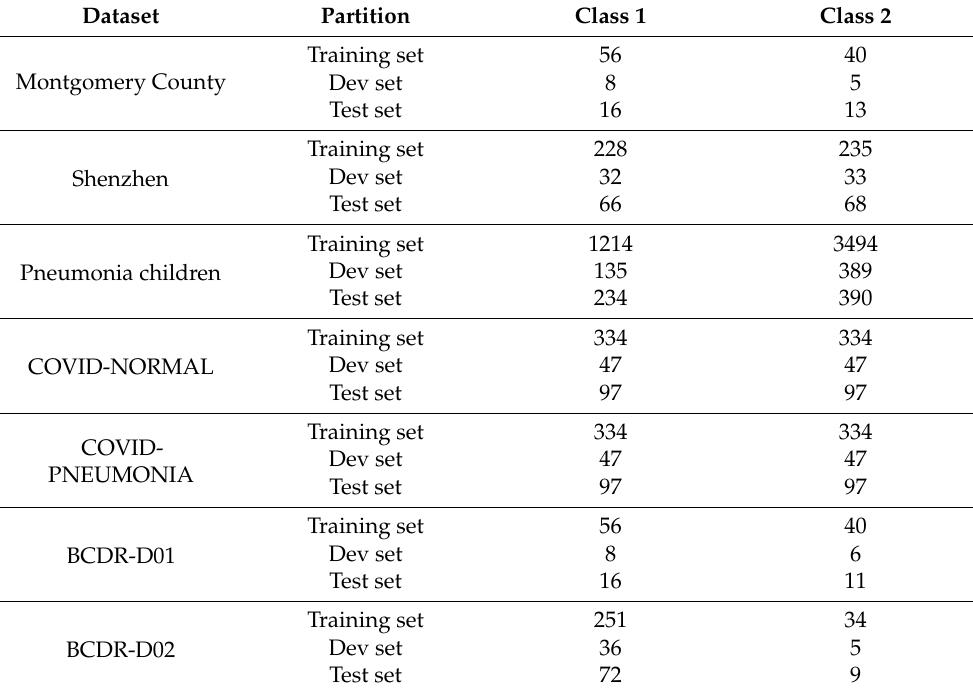
Table 3. Partitions for each dataset.